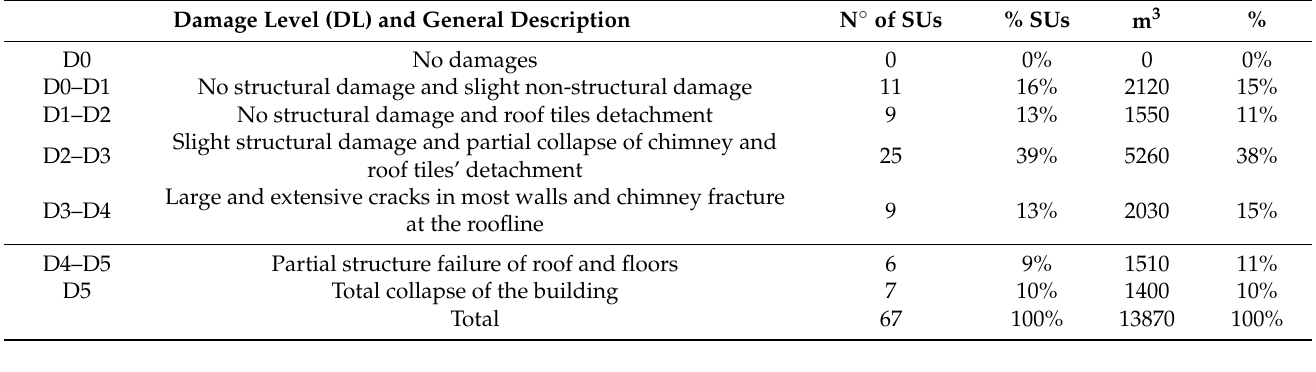
Table 4. Damage distribution organized according to the volume and the number of buildings involved.